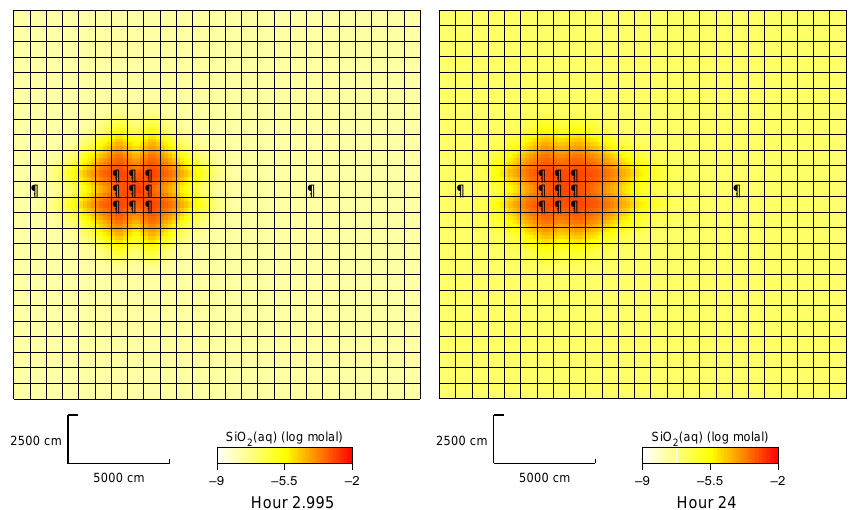
Figure 4. Plan view of SiO 2(aq) concentrations around the group of 9 injection wells, in quartz aquifer, 3 and 24h after the silicate fluid